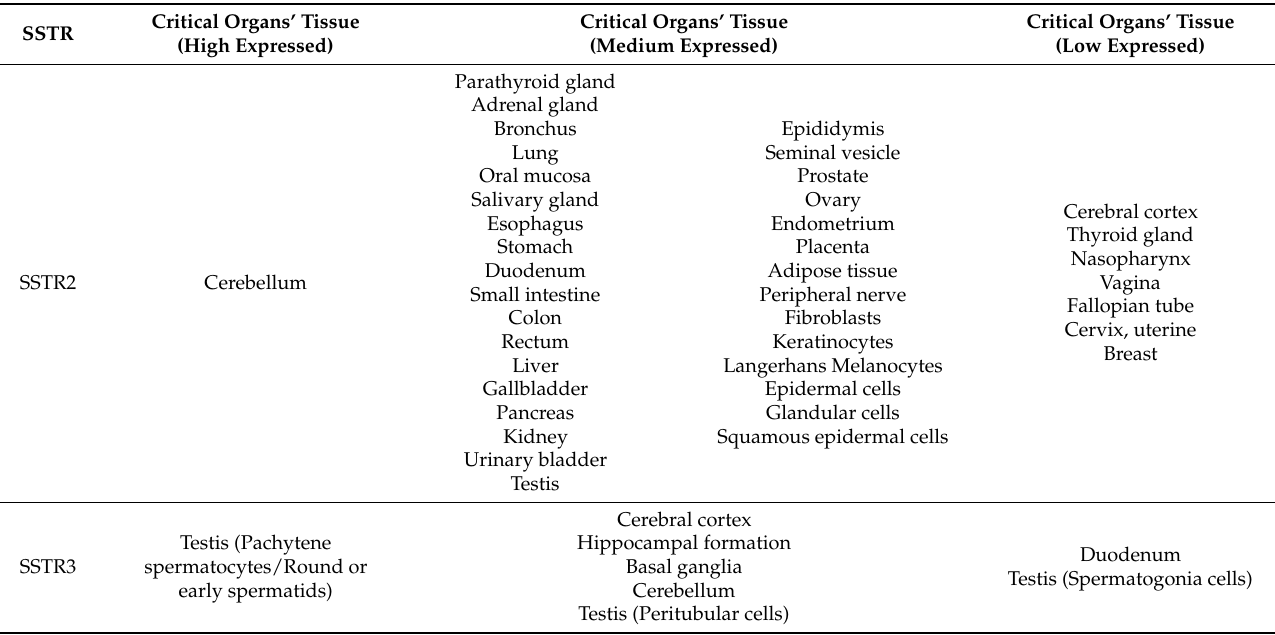
Table 3. SSTR subtypes expression score (From the Human Protein Atlas https://www.proteinatlas. org/ (accessed on 1 April 2022)). General comparison of expression origins between the most important SSTR (subtype 2) and the less important one (subtype 3) in NET